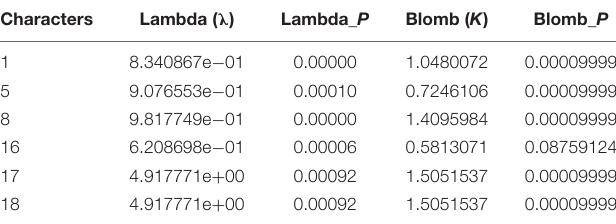
TABLE 5 | Six characters test well congruent with molecular